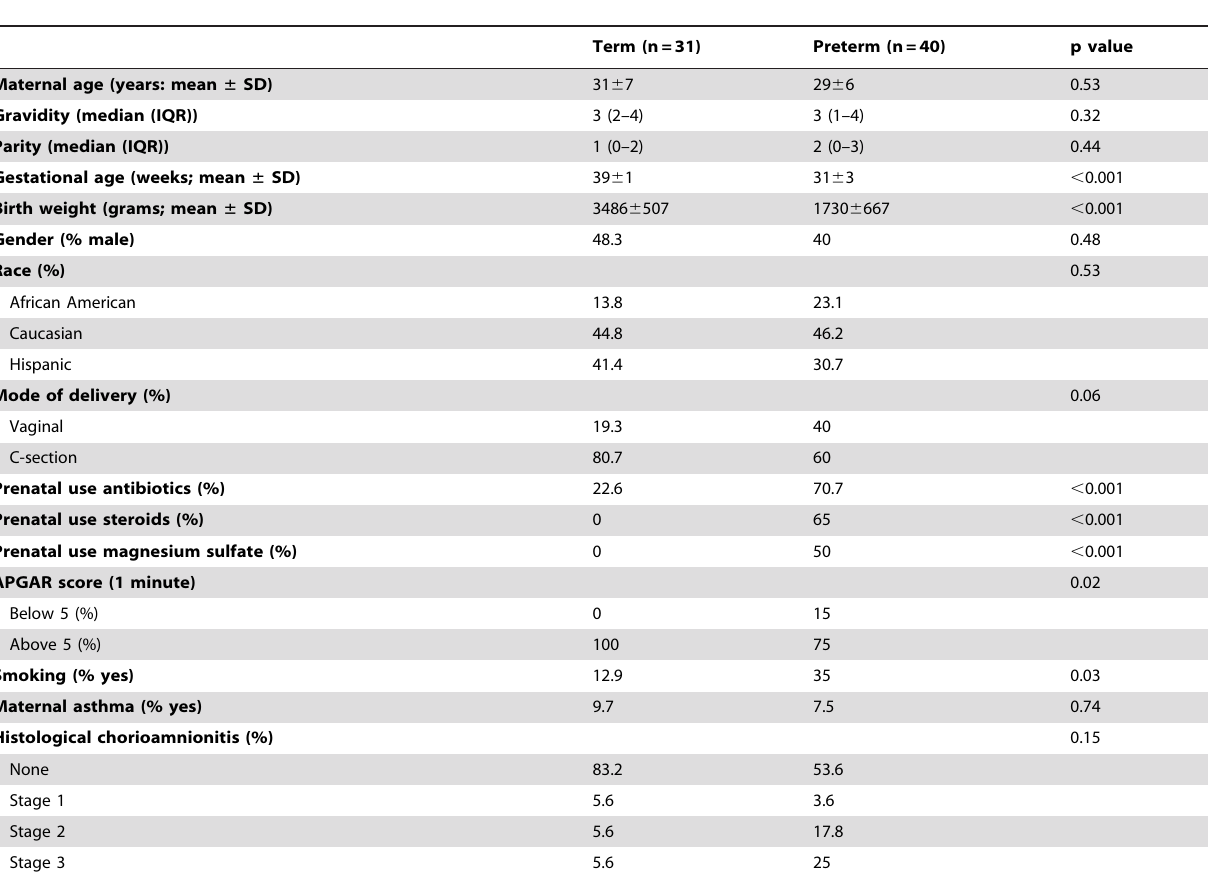
Table 2. Maternal and Infant